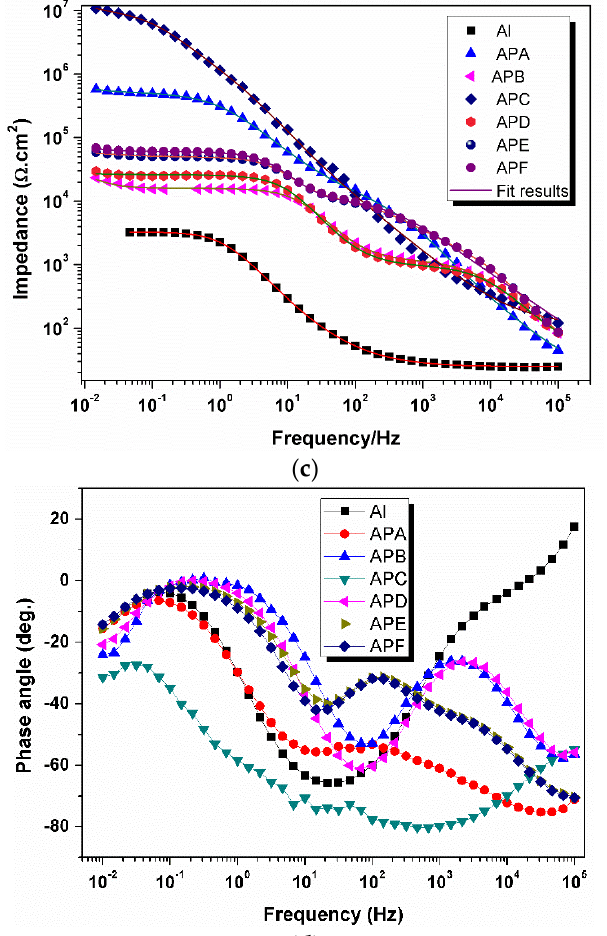
Figure 15. Nyquist plots of ( a ) PEO coatings and uncoated pure aluminum for 6 h immersion time, ( b ) the enlarged plots of the lower left region in Figure ( a ), and the ( c ) Bode modulus and ( d ) Bode phase plots of PEO coatings and uncoated pure aluminum.